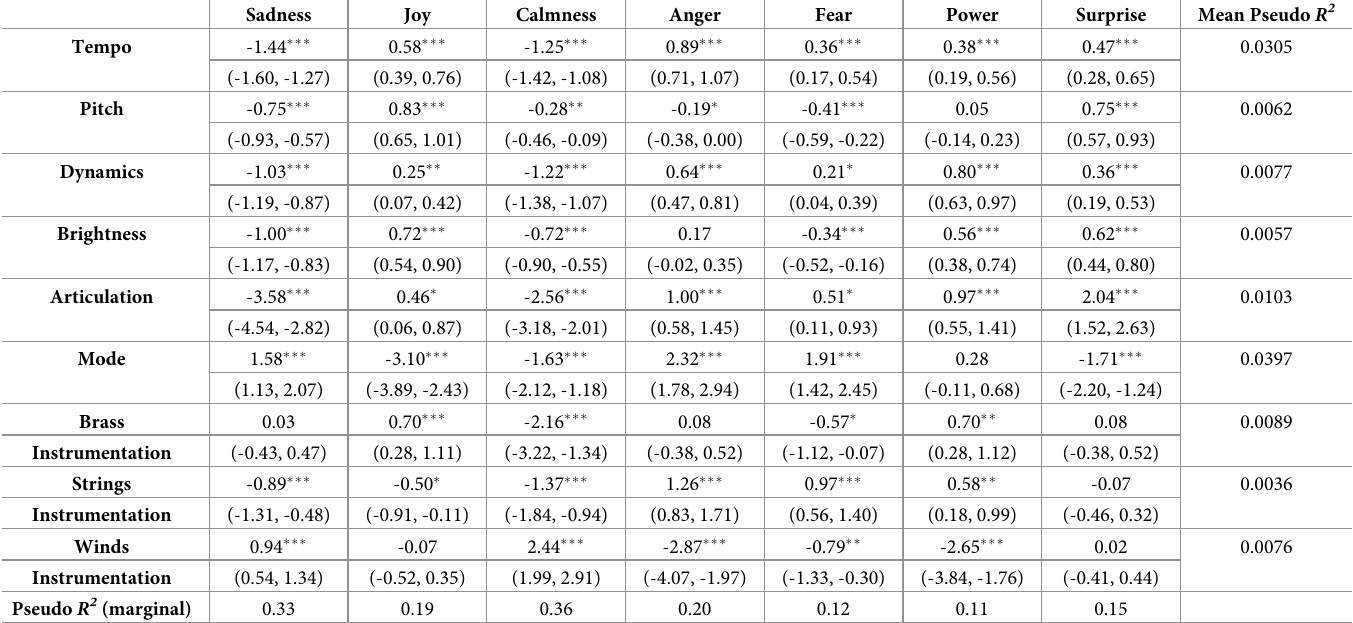
Table 2. Linear Mixed Model (LMM) results for seven emotions across all cues in Experiment 1. The numbers are standardised betas (z-scores) with their 2.5% and 97.5% confidence intervals shown in